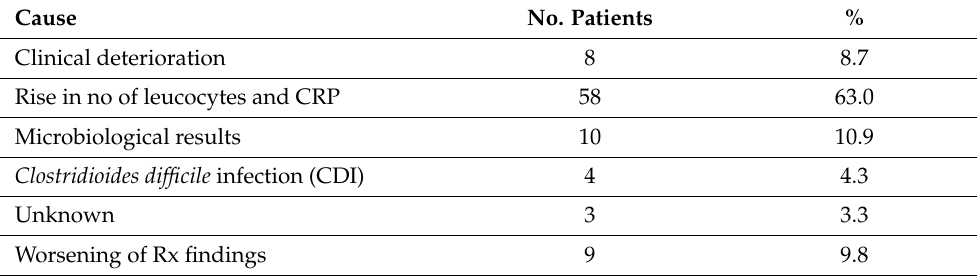
Table 2. Recorded causes of antibiotic changes in the COVID 19 ICU patients.